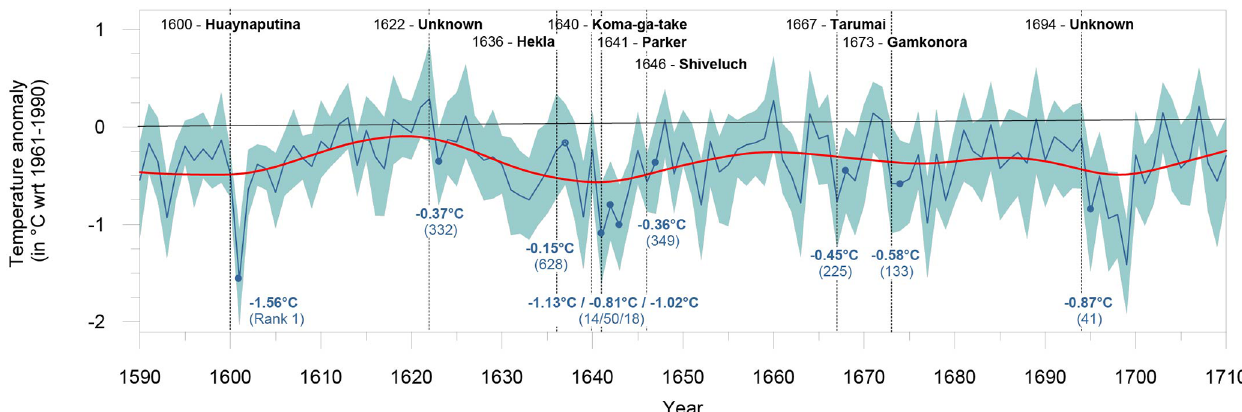
Figure 4. Tree-ring-based (NVOLC v2; Guillet et al., 2020) Northern Hemisphere (NH; 40–90 ◦ N) summer (JJA) temperature reconstruction of the 17th century with volcanic eruptions and the associated cooling highlighted with blue dots. The rank values (in parentheses) indicate the amount of cooling induced by the eruption compared to all cooling events recorded over the past 1500 years. Volcanic cooling is calculated for all major 17th-century eruptions: 1600 Huaynaputina, 1636 Hekla, 1640/41 Komaga-take/Mount Parker, 1646 Shiveluch, and the 1694 unidentified